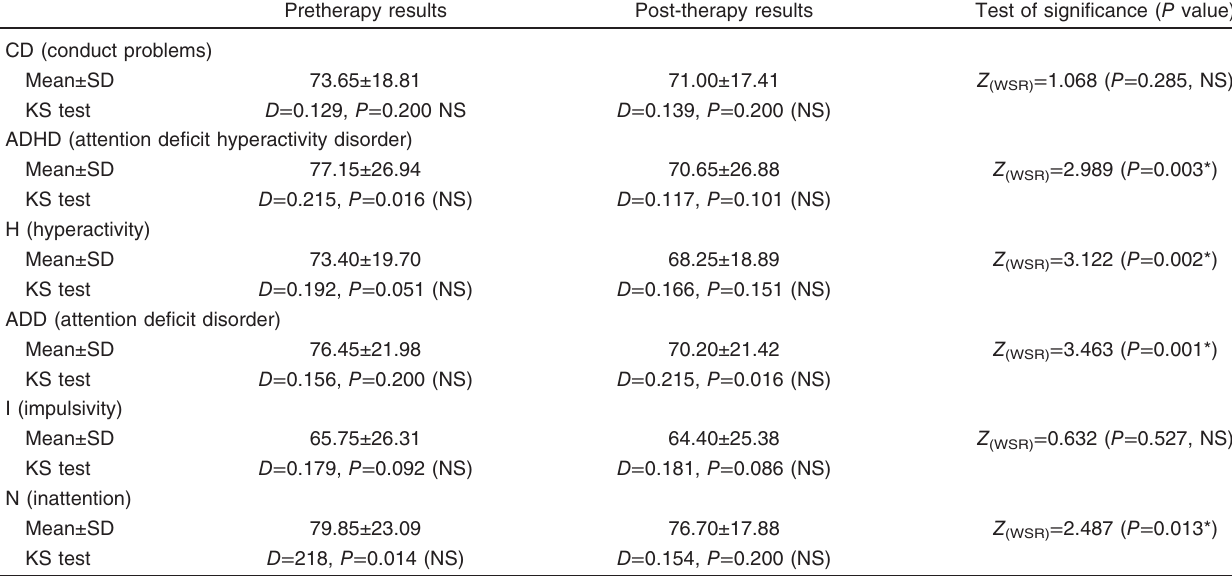
Table 3 Pretherapy and post-therapy results of childhood attention and adjustment survey